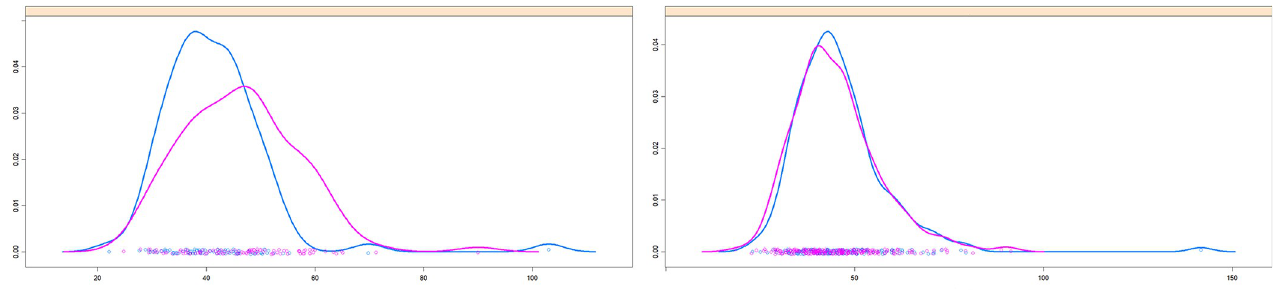
Fig 5. Probability density functions for pO 2 -records of affected (pink curves) and control (blue curves) patients. Left panel: Extremely preterm infants. Right panel: Very preterm infants.